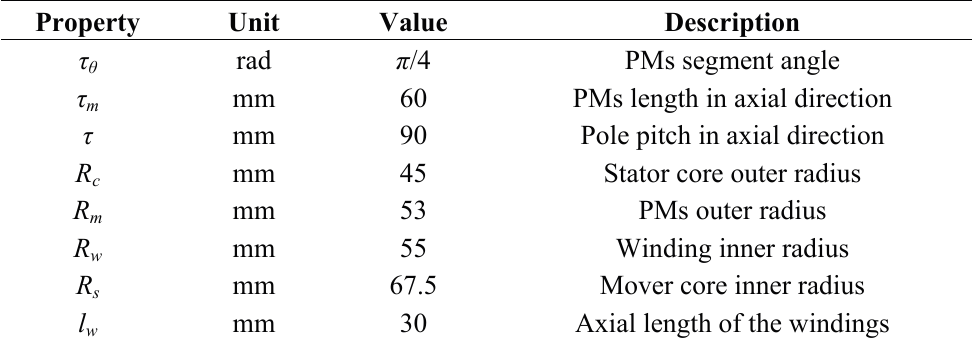
Table 1. Constructive parameters of the actuator.